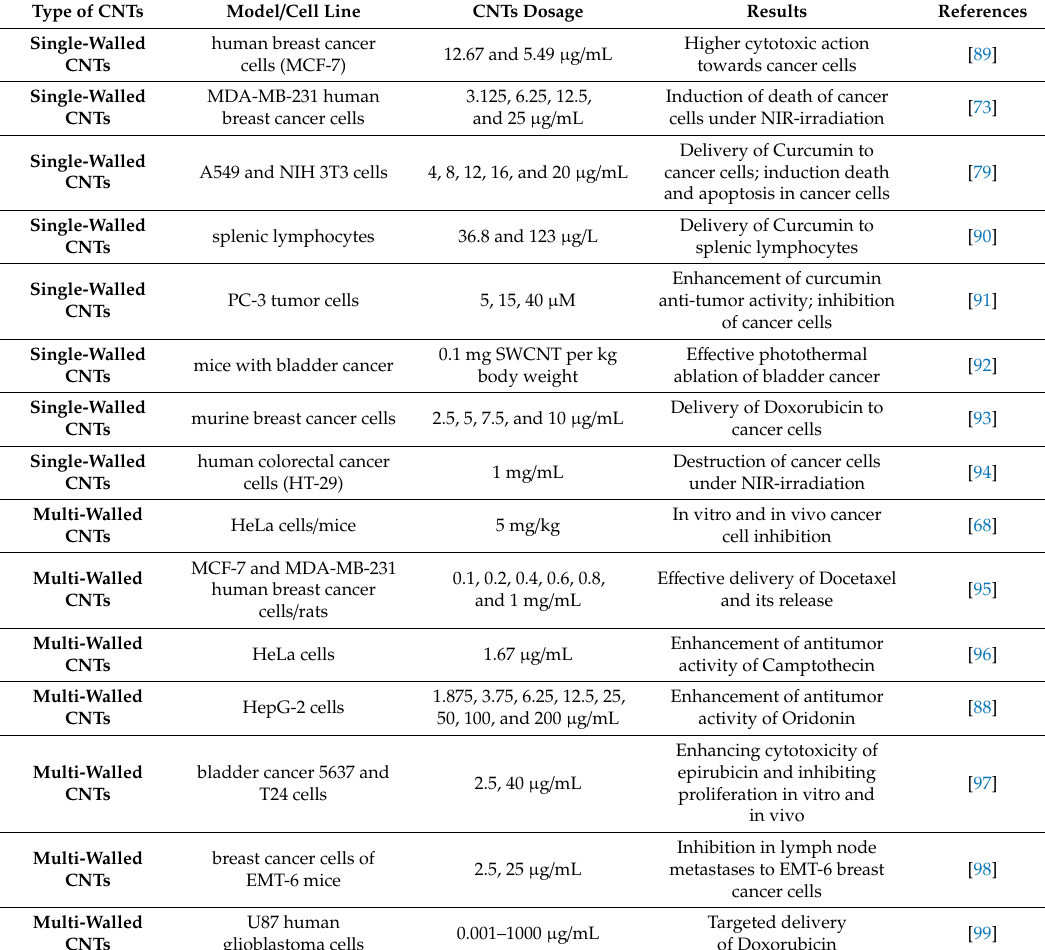
Table 2. Examples of the studies on the applications of carbon nanotubes in cancer